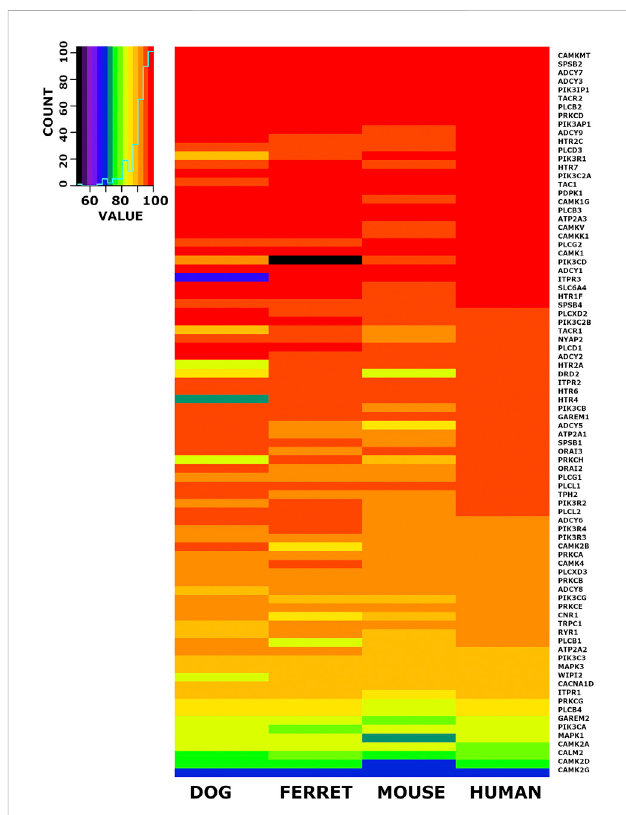
FIGURE 6 Heat Map Illustrating Identity Between Shrew Protein and Orthologs of Emesis Candidate Genes. A set of 84 cDNAs from the emesis candidate gene set was compared at the inferred amino acid levelbetweenshrewanddog,ferret,mouseandhuman.Resultsare represented in heat map format. The color key and histogram in the upper left corner provides a mapping between heat map colors and the count of cDNAs in each color category. The data is ordered by the nucleotide identity relationship between shrew cDNAs and corresponding orthologous human cDNAs in the last